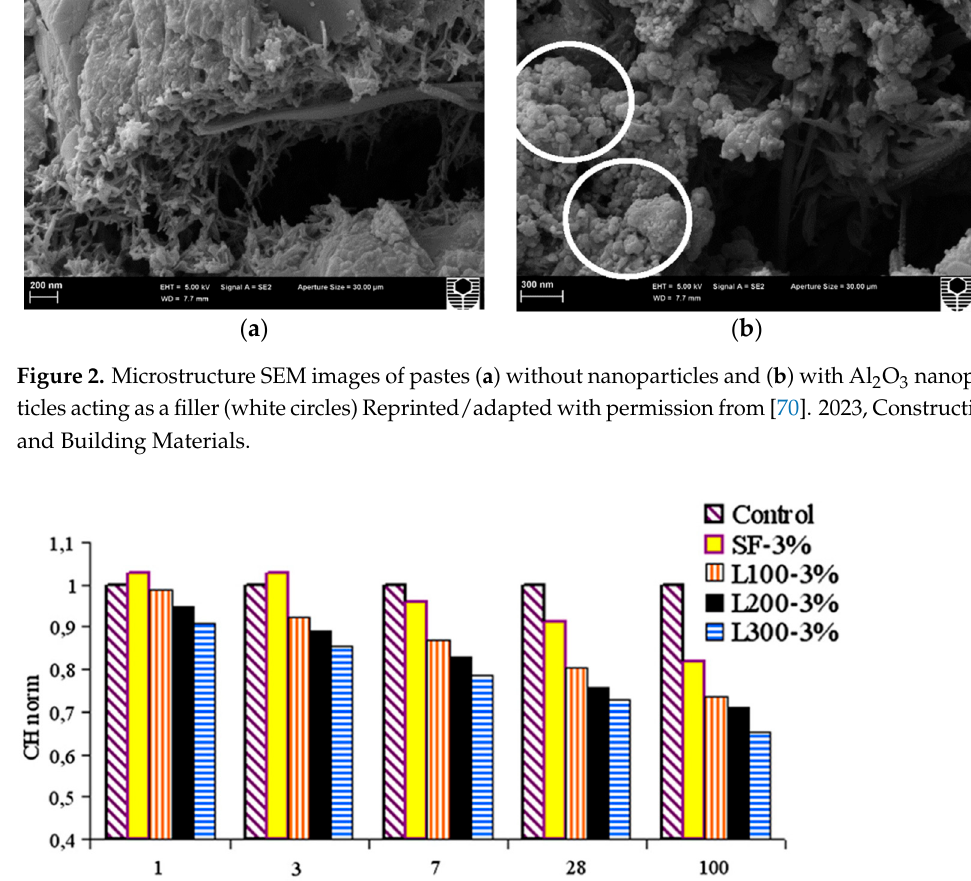
Figure 2. Microstructure SEM images of pastes ( a ) without nanoparticles and ( b ) with Al 2 O 3 nano- particles acting as a filler (white circles) Reprinted/adapted with permission from [70]. 2023, Con- struction and Building Materials.